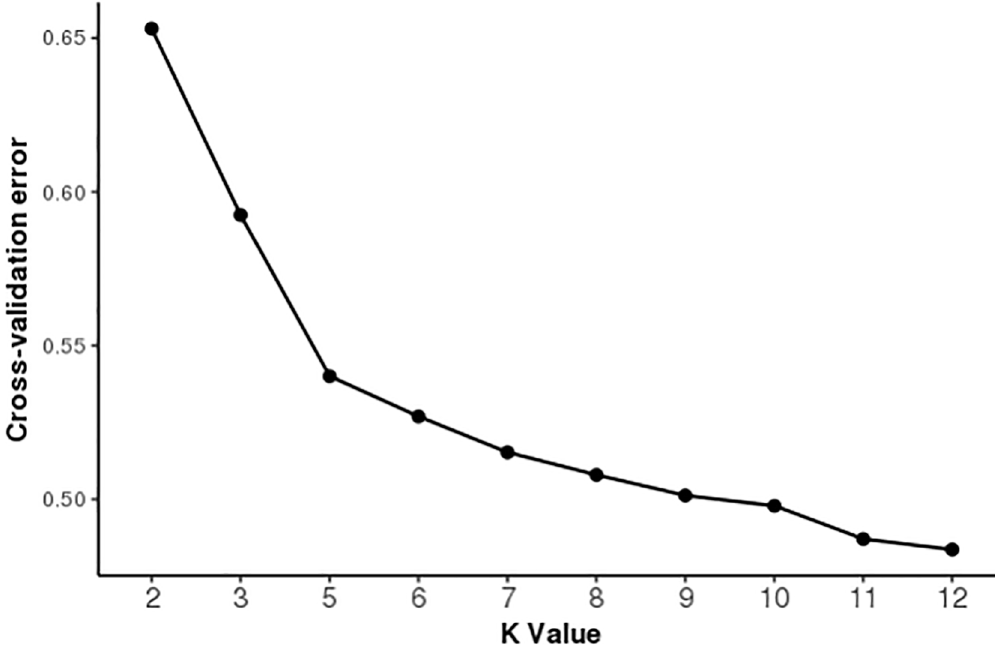
Fig 4. Cross validation plot indicating the model suitability as the number of putative populations (K) increases.